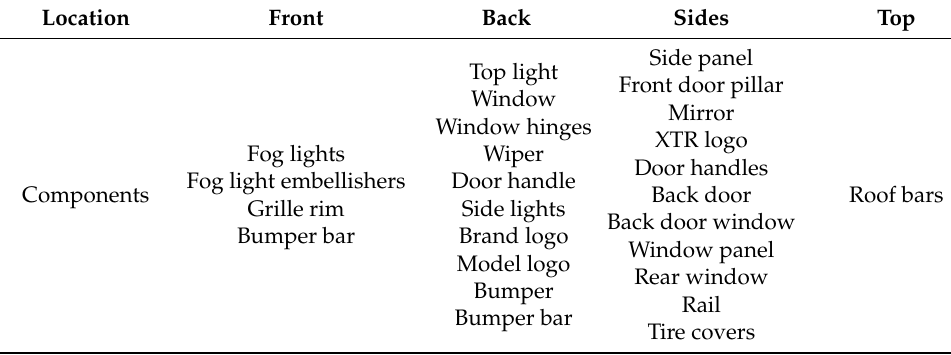
Table 1. List of all variable component types according to their planes of location. Location Front Back